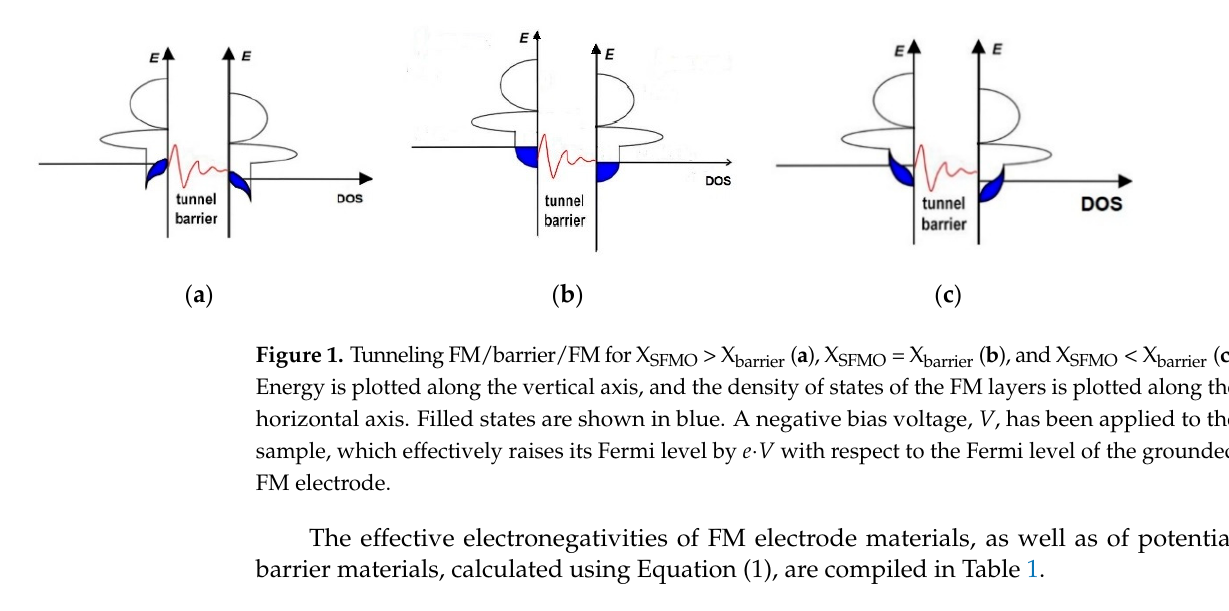
Table 1. Effective electronegativities of ferro and FM electrode materials, as well as of potential barrier materials.